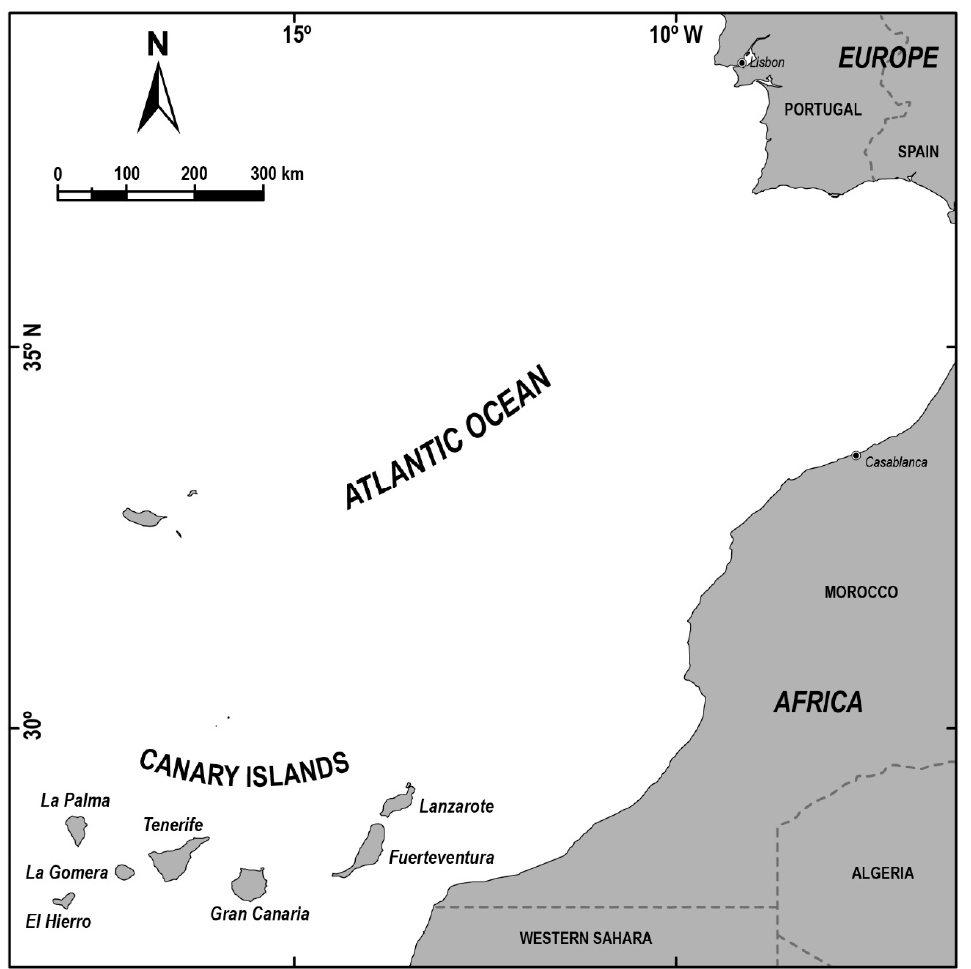
Figure 1. Location of the Canary Islands.